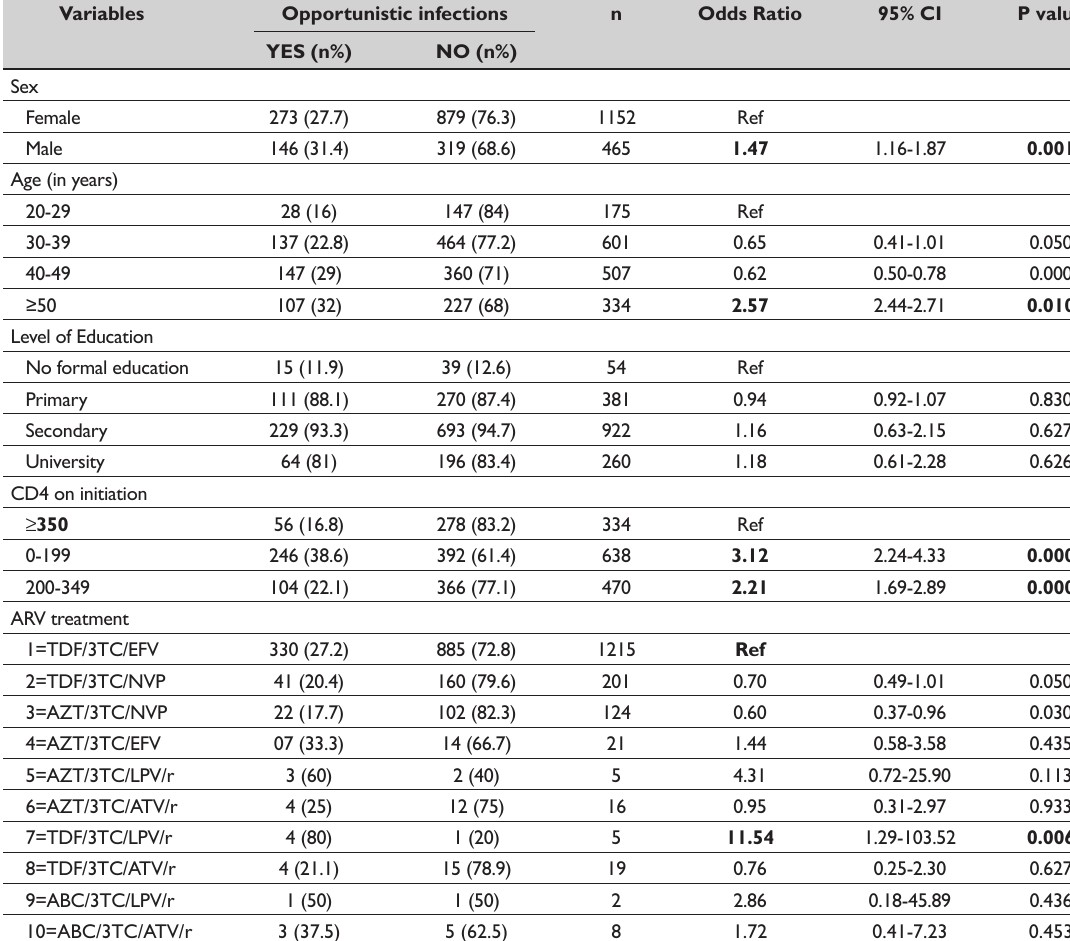
Table 8: Multivariate analysis